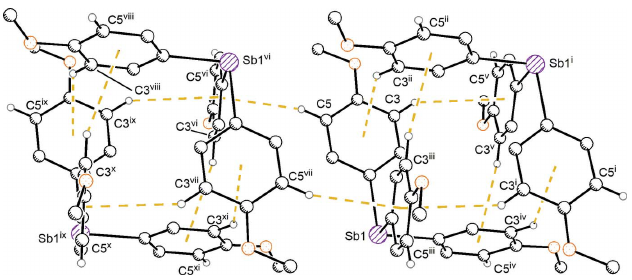
Figure 3 All C—H (cid:2)(cid:2)(cid:2) (cid:2) interactions, shown as dashed lines, in two adjacent dimeric units. Hydrogen atoms not involved in interactions are omitted for clarity. Symmetry codes: (i) (cid:5) x , (cid:5) y, 1 (cid:5) z ; (ii) y , y (cid:5) x , 1 (cid:5) z ; (iii) y (cid:5) x , (cid:5) x , z ;